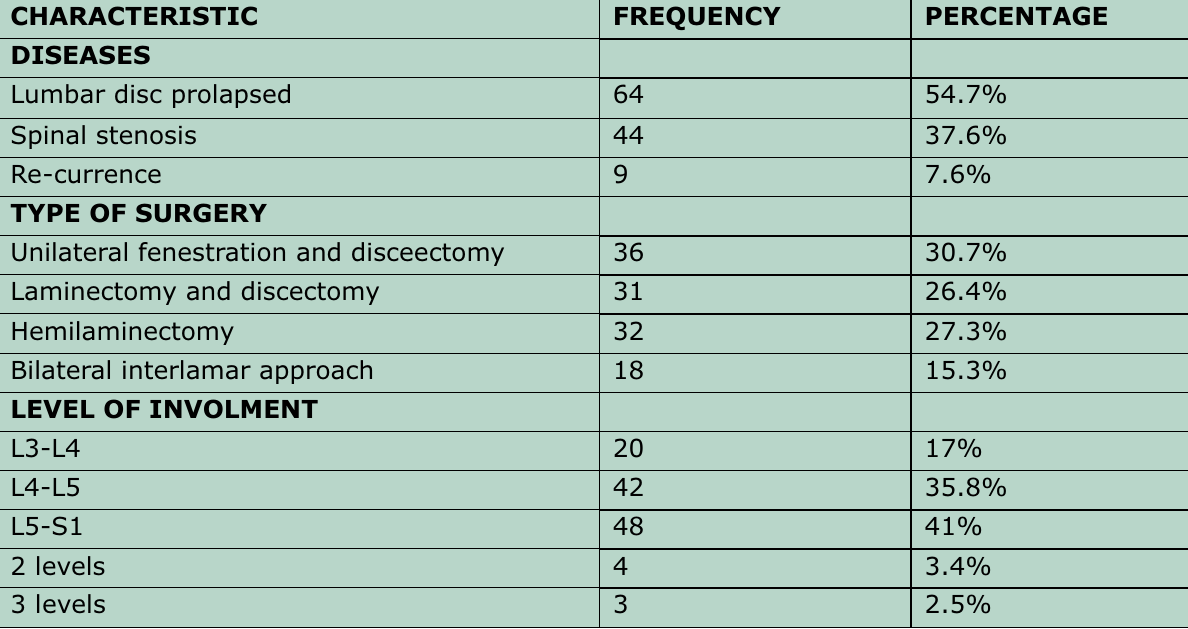
Table-II. C  haracteristic of patients (n=117).